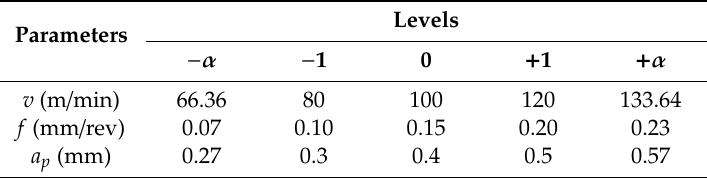
Table 3. Process parameters and their levels.